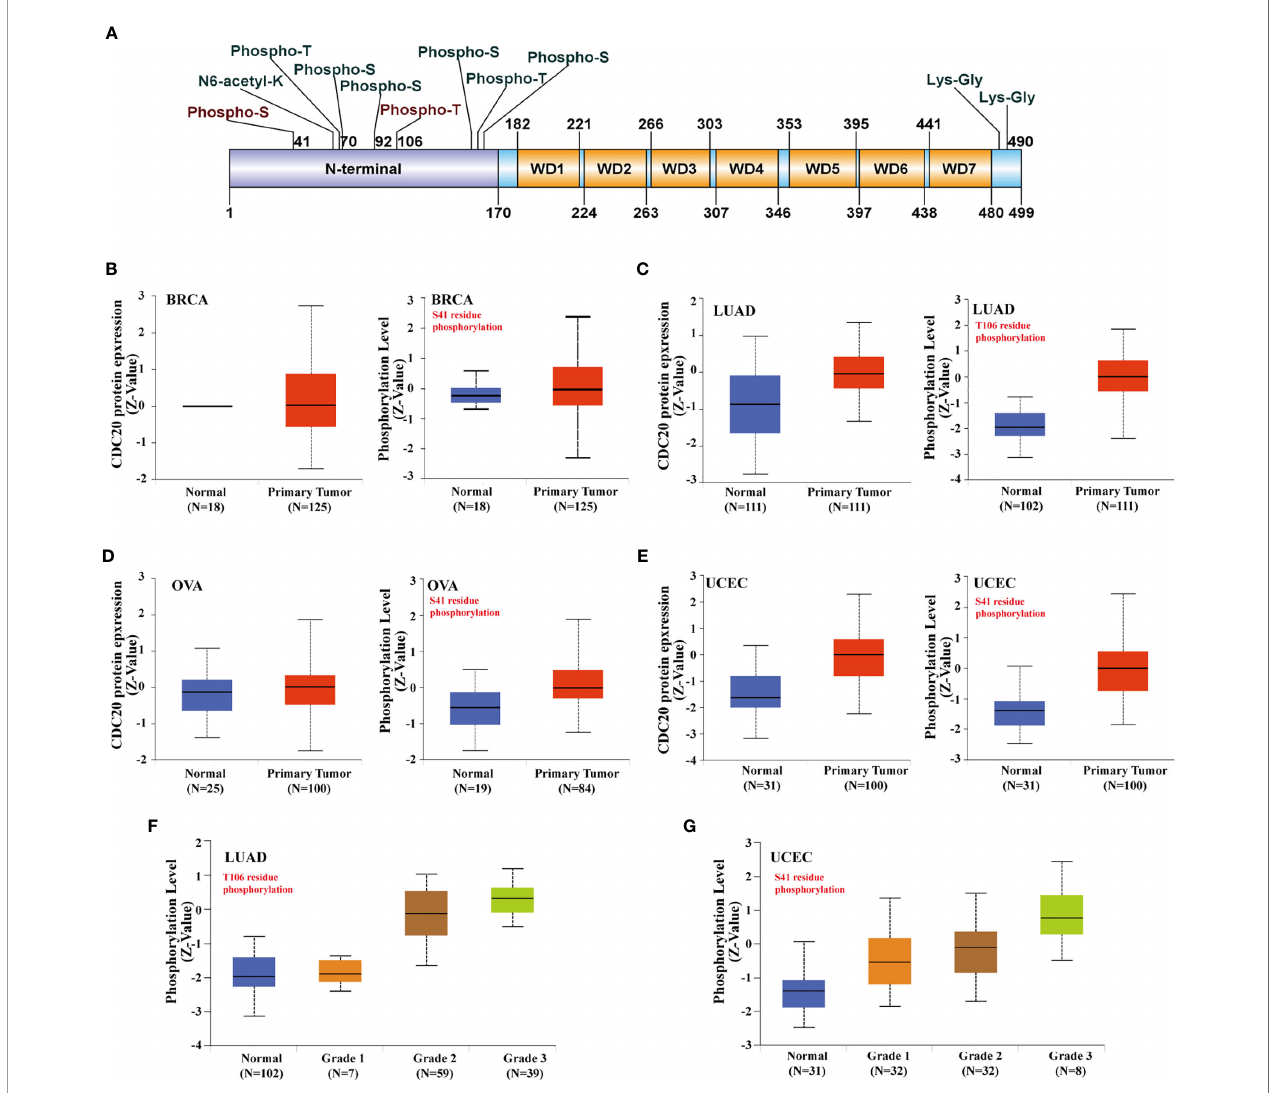
FIGURE 3 | Phosphorylation of Cdc20 protein in different cancer types and its clinical signi fi cance. (A) The phosphorylation sites of Cdc20 that have been veri fi ed are displayed in the schematic diagram of Cdc20 protein. Based on the CPTAC dataset, we analyzed the expression level of total Cdc20 protein and phosphorylated Cdc20 protein (S41 and T106 sites) between primary tumors of selected tumors and corresponding normal tissue via the UALCAN. (B) The protein abundance of Cdc20 total protein(left) and S41-phosphorylated protein(right) in BRCA tumor tissues and normal tissues, visualized in box plots. (C) The protein abundance of Cdc20 total protein(left) and T106-phosphorylated protein(right) in LUAD tumor tissues and normal tissues, visualized in box plots. (D) The protein abundance of Cdc20 total protein(left) and S41-phosphorylated protein(right) in OVA tumor tissues and normal tissues, visualized in box plots. (E) The protein abundance of Cdc20 S41- phosphorylated protein(right) in UCEC tumor tissues and normal tissues, visualized in box plots. (F) The protein abundance of Cdc20 T106-phosphorylated protein (right) in LUAD normal tissues and tumor tissues of different grades (grade1, grade2, grade3), visualized in box plots. (G) The protein abundance of Cdc20 S41- phosphorylated protein(right) in UCEC normal tissues and tumor tissues of different grade(grade1, grade2, grade3), visulized in box